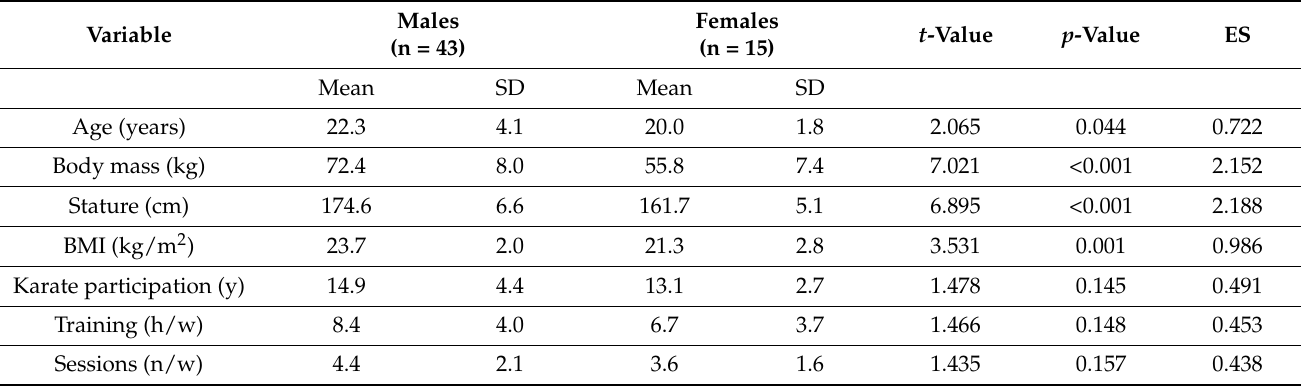
Table 1. Characteristics of male and female karatekas. Mean ± standard deviation (SD). Student’s t -test.